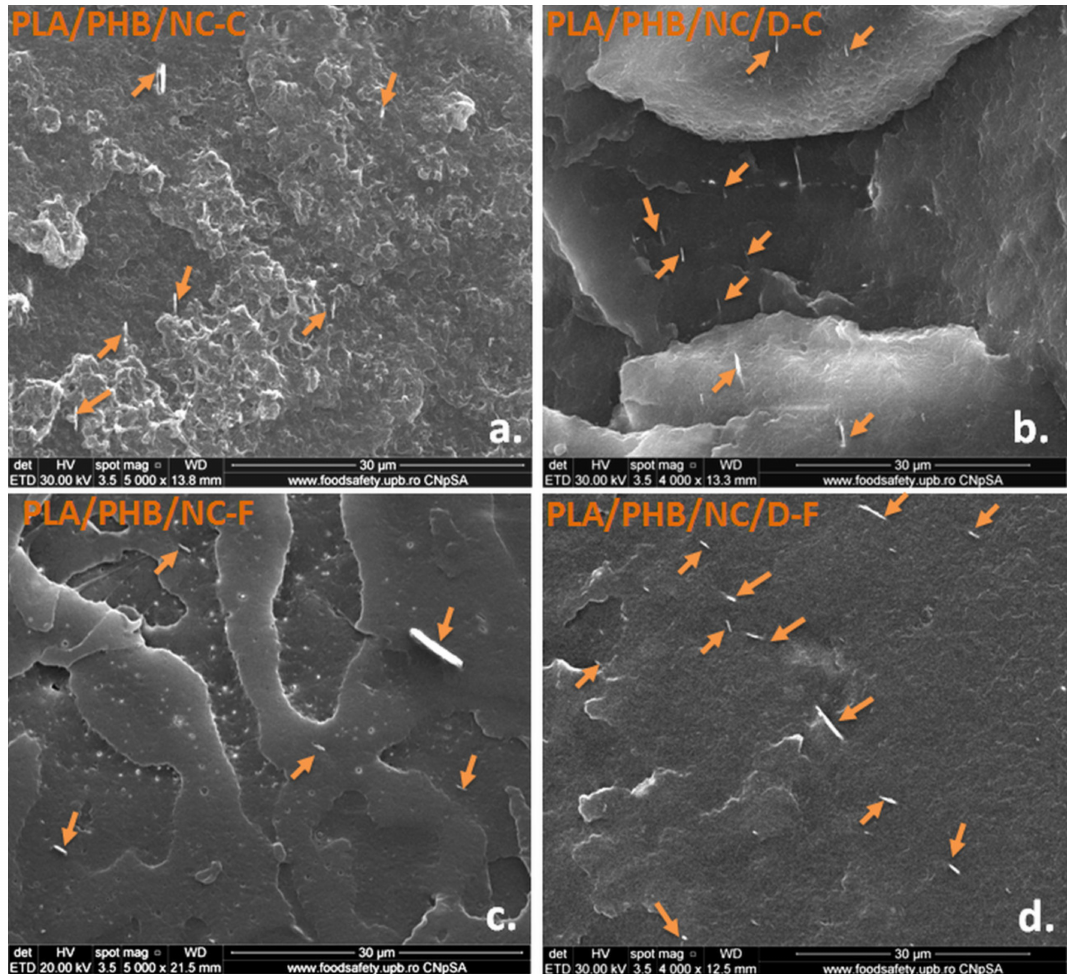
Figure 3. SEM images of cryo-fractured surface of the obtained nanocomposites as films ( a , b ) and filaments ( c , d